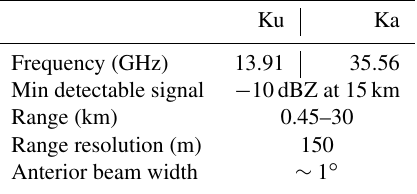
Table 2. Some D3R parameters relevant for this study. Full D3R specifications can be found in Vega et al. (2014).